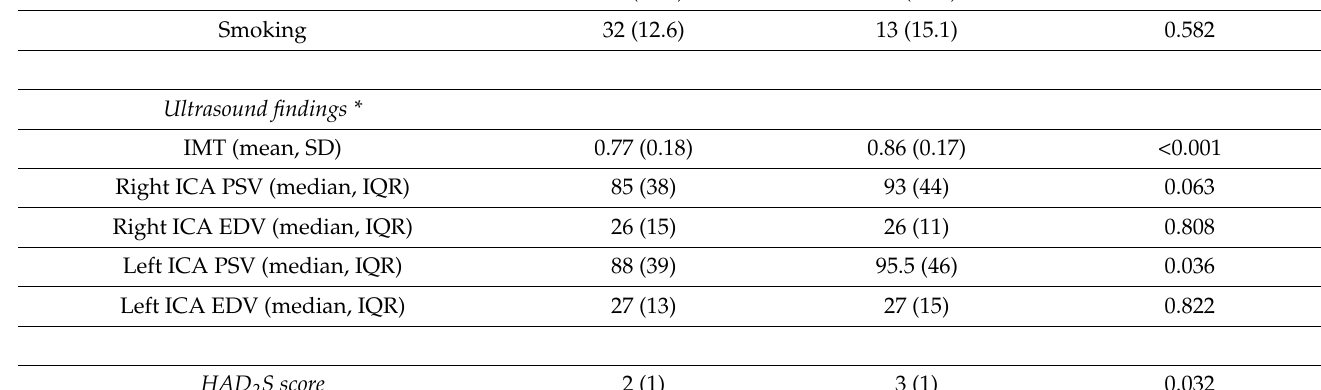
Table 3. Binary logistic regression analysis of independent determinants of plaque progression.